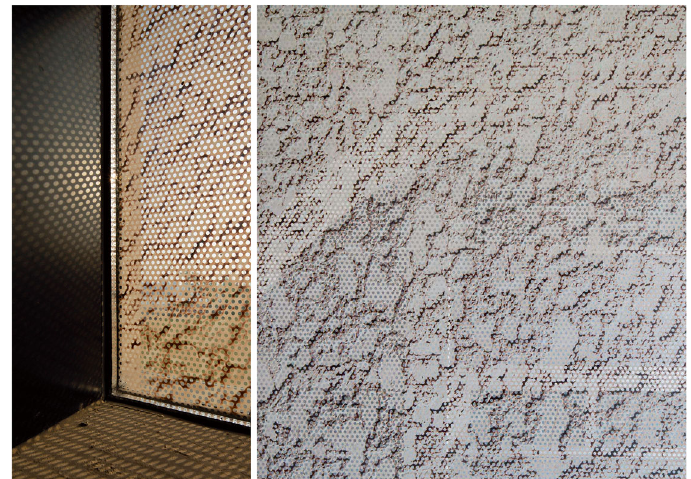
Fig. 12 Details of the screen-printed glass panels (Source: left by Tianzhou Yang; right by Fangfang Tian)